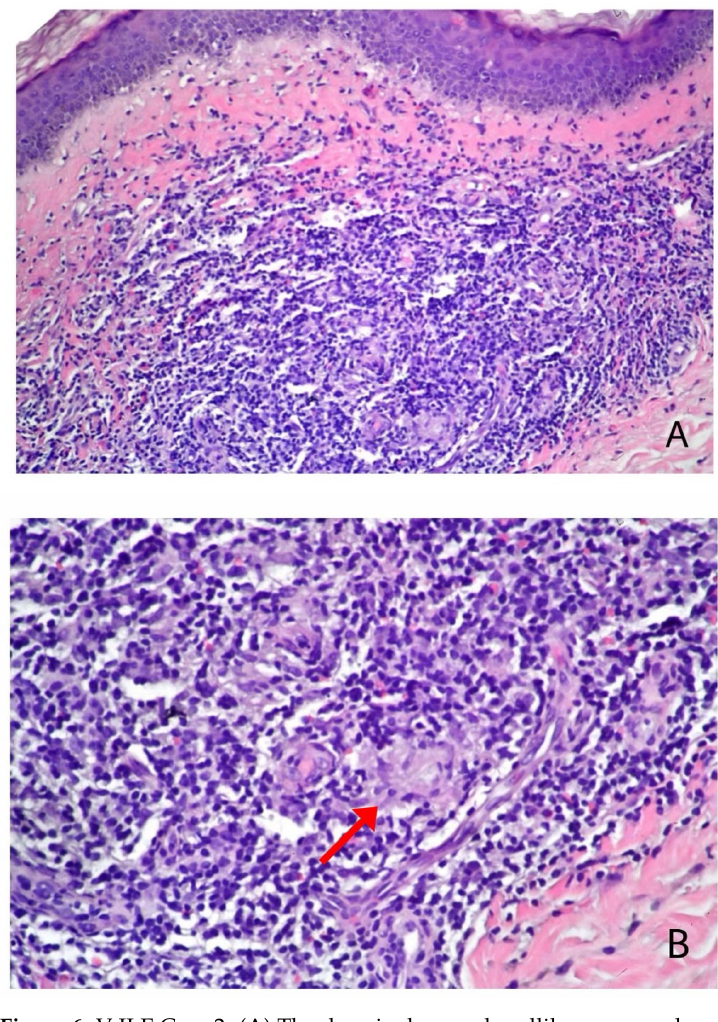
Figure 6. V-ILE Case 2. ( A ) The dermis shows a bandlike mononuclear infiltrate. Interspersed are scattered collections of epithelioid histiocytes. ( B ) Higher power showing epithelioid histiocytes (arrow). ( A,B ) Hematoxylin-eosin stain; Original magnification. ( A ), ×100; ( B ), ×200.